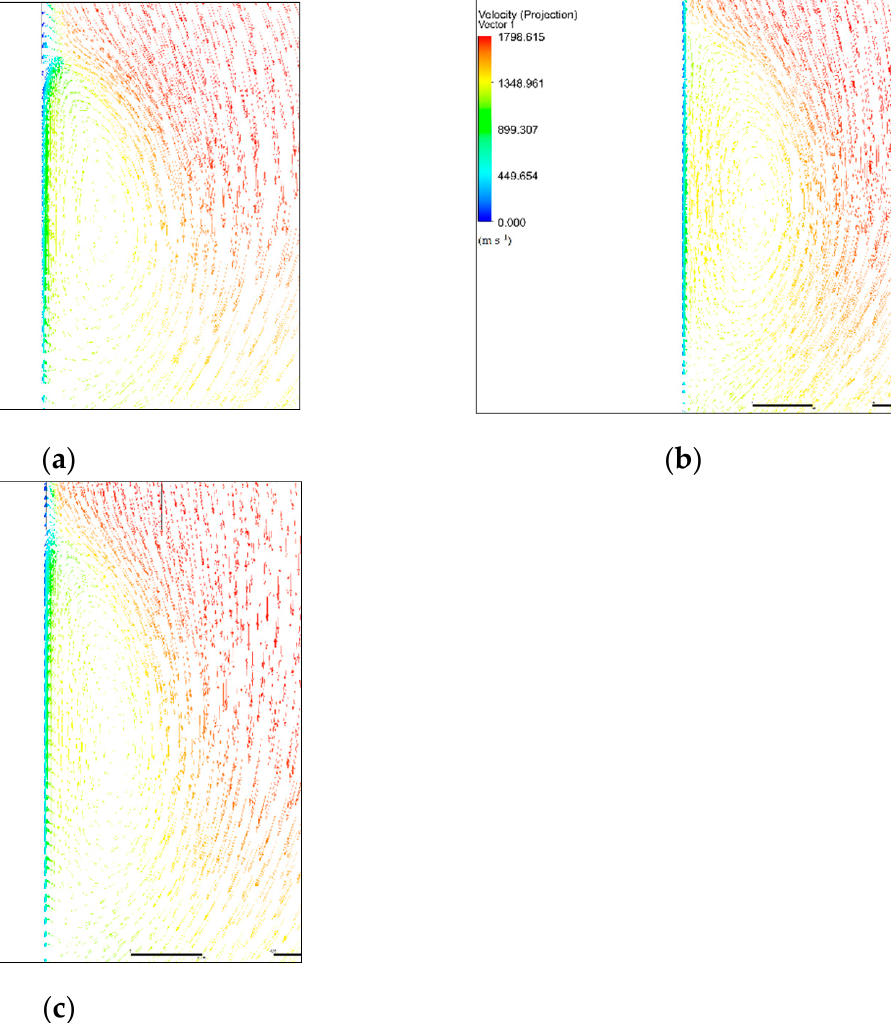
Table 9. SVT efficiency with the same Reynolds